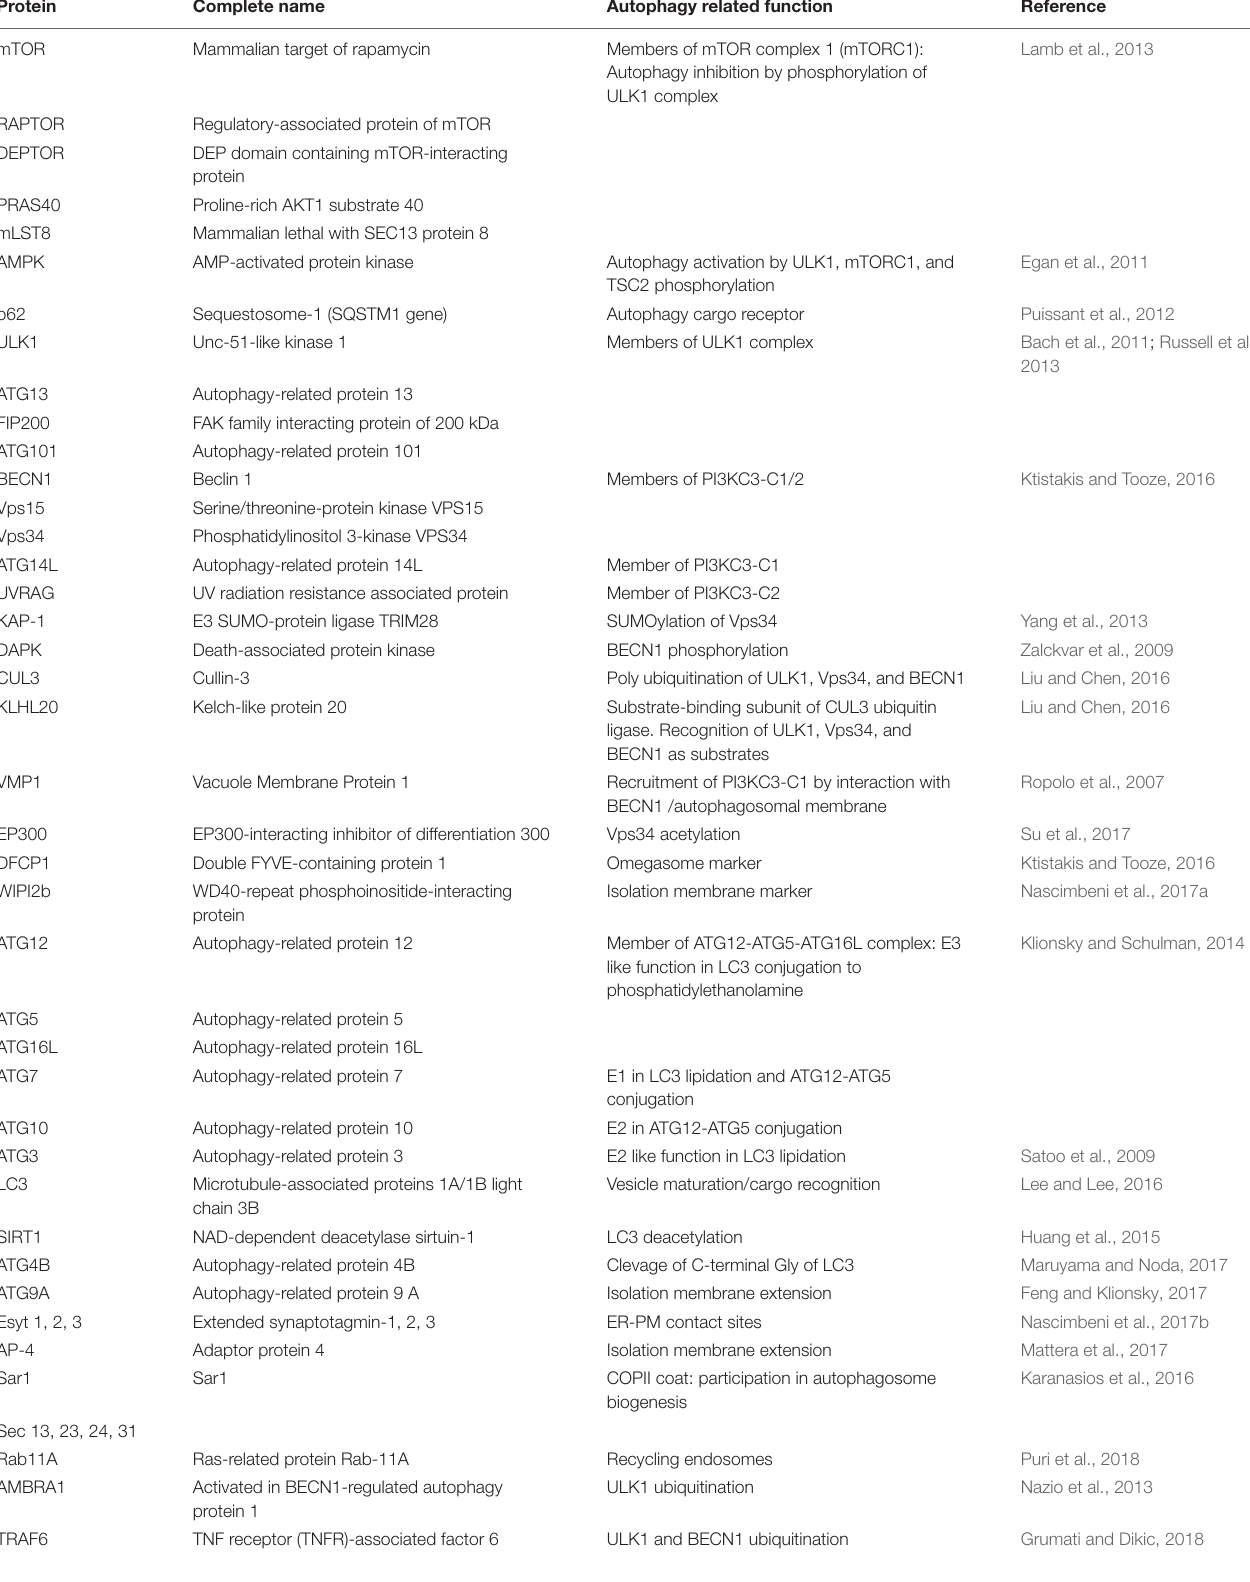
TABLE 1 | Main molecules involved in the initial steps of mammalian autophagosome biogenesis.